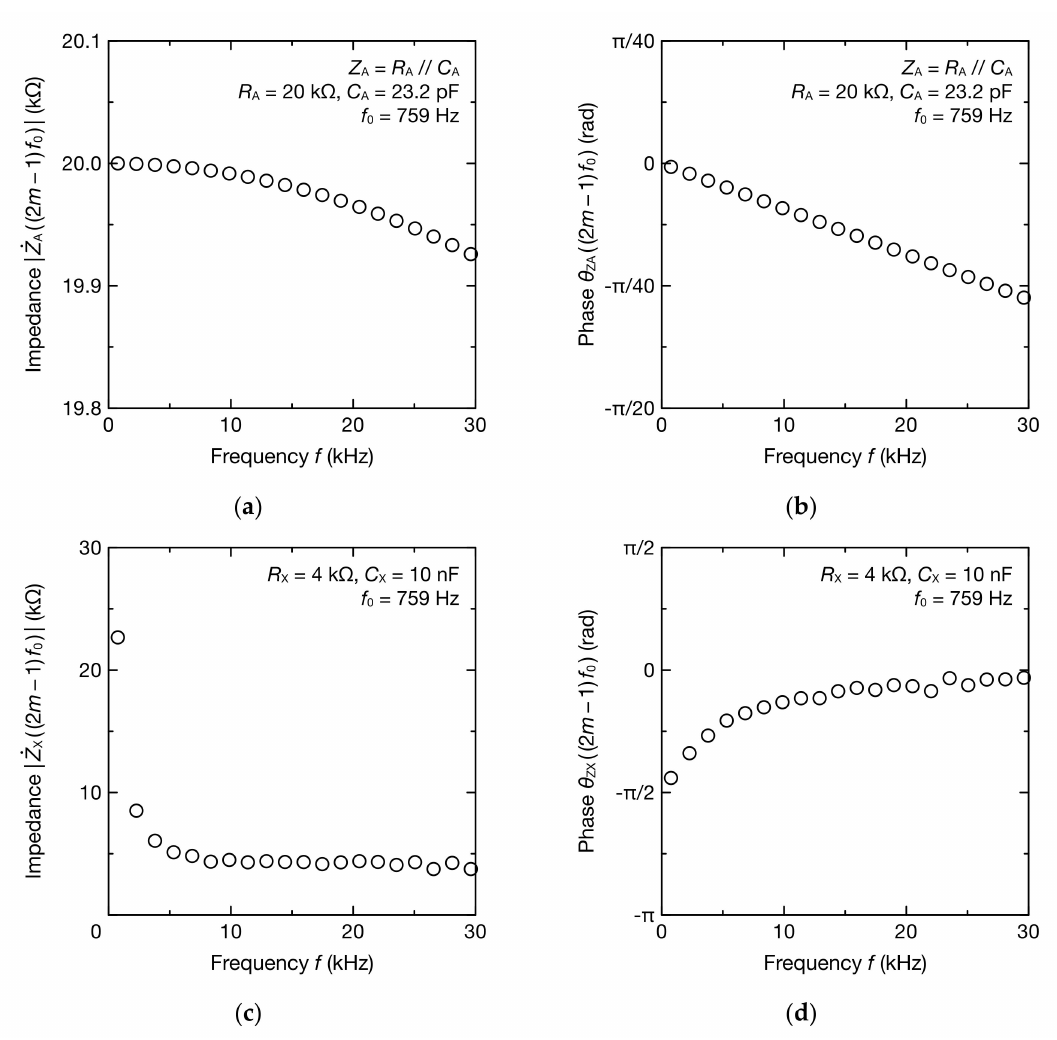
(cid:12) (cid:12) . (cid:12) (cid:12) (cid:12) (cid:12) Z A (cid:12) (cid:12) ; ( b ) phase